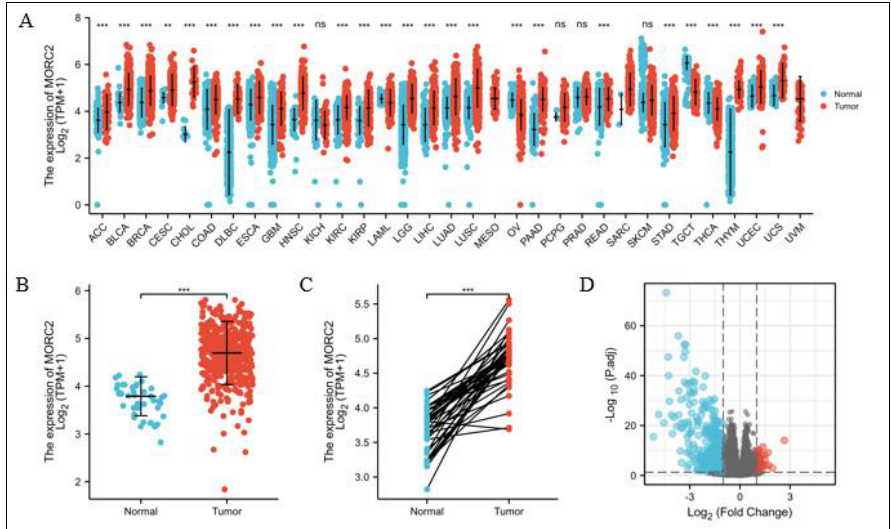
Figure 1. Differential mRNA expression profiles in CRC patients stratified by MORC2 levels. ( A ) The comparison of MORC2 expression between tumor and peri-carcinous tissue in different types of cancers based on the TCGA database. ( B , C ) MORC2 expression is higher in CRC tumors than peri-carcinous tissue from TCGA-CRC in the paired experimental group and the unpaired experi- mental group. ( D ) Expressed mRNAs between high- and low-MORC2 groups are presented in vol- cano plots. ns, p ≥ 0.05; ** p < 0.01; *** p < 0.001.